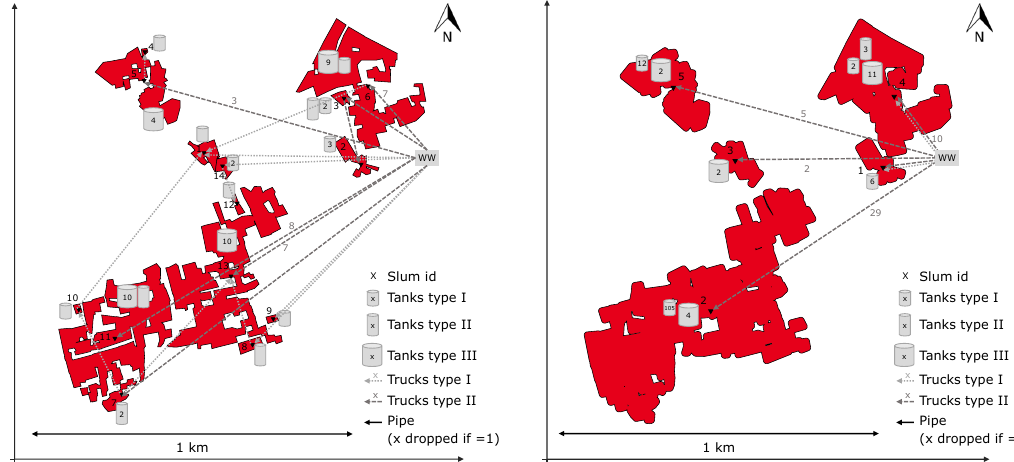
Figure 13. Optimization result for a slum cluster in Dhaka 2010, Bangladesh, with 14 slums (left) and with low resolution, with a buffer of 10 m